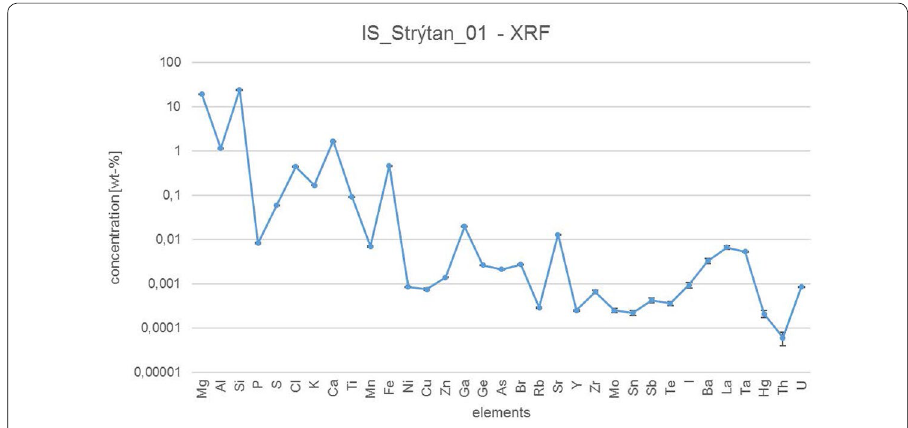
Fig. 4 XRF analysis results for sample IS_Strýtan_01. All elements above the detection limit are shown. Table 1 gives the complete dataset